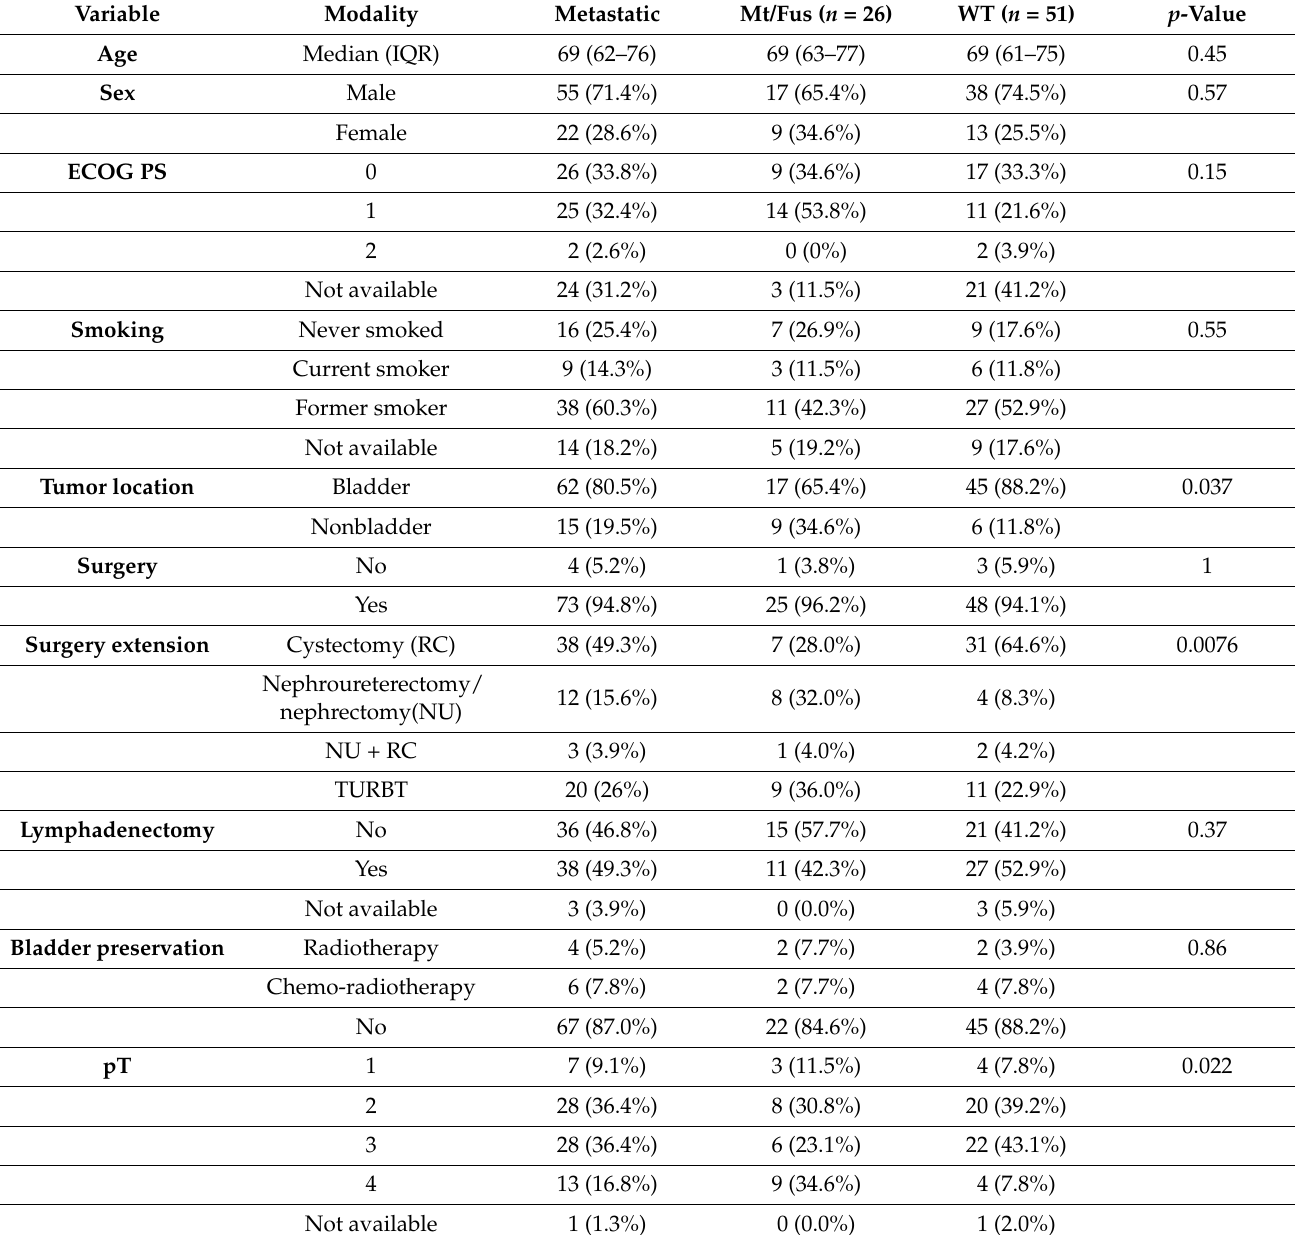
Table 1. Study population demographics ( n = 77) and comparison between FGFR GA and WT